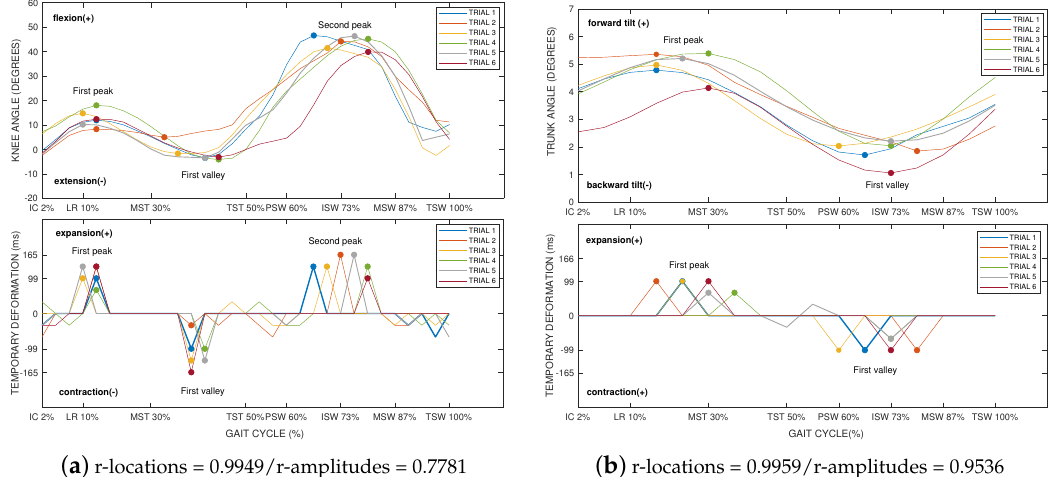
Figure 7. Examples of the kinematic joint angles and the corresponding temporary deformations represented only on the Kinect signal. The first Pearson correlation was calculated between the locations (r-location) of peaks and valleys of the signal and the locations of the corresponding temporary deformations. A second Pearson correlation was calculated between the amplitudes (r-amplitudes) of peaks and valleys of the signal and the amplitudes of the corresponding temporary deformations. To achieve a better understanding of the areas where temporary deformations occur, the phases of the gait cycle have been identified: initial contact (IC—2%), loading response (LR—10%), mid stance (MSt—30%), terminal stance (TSt—50%), pre-swing (PSw—60%), initial swing (ISw—73%), mid swing (MSw—87%), and terminal swing